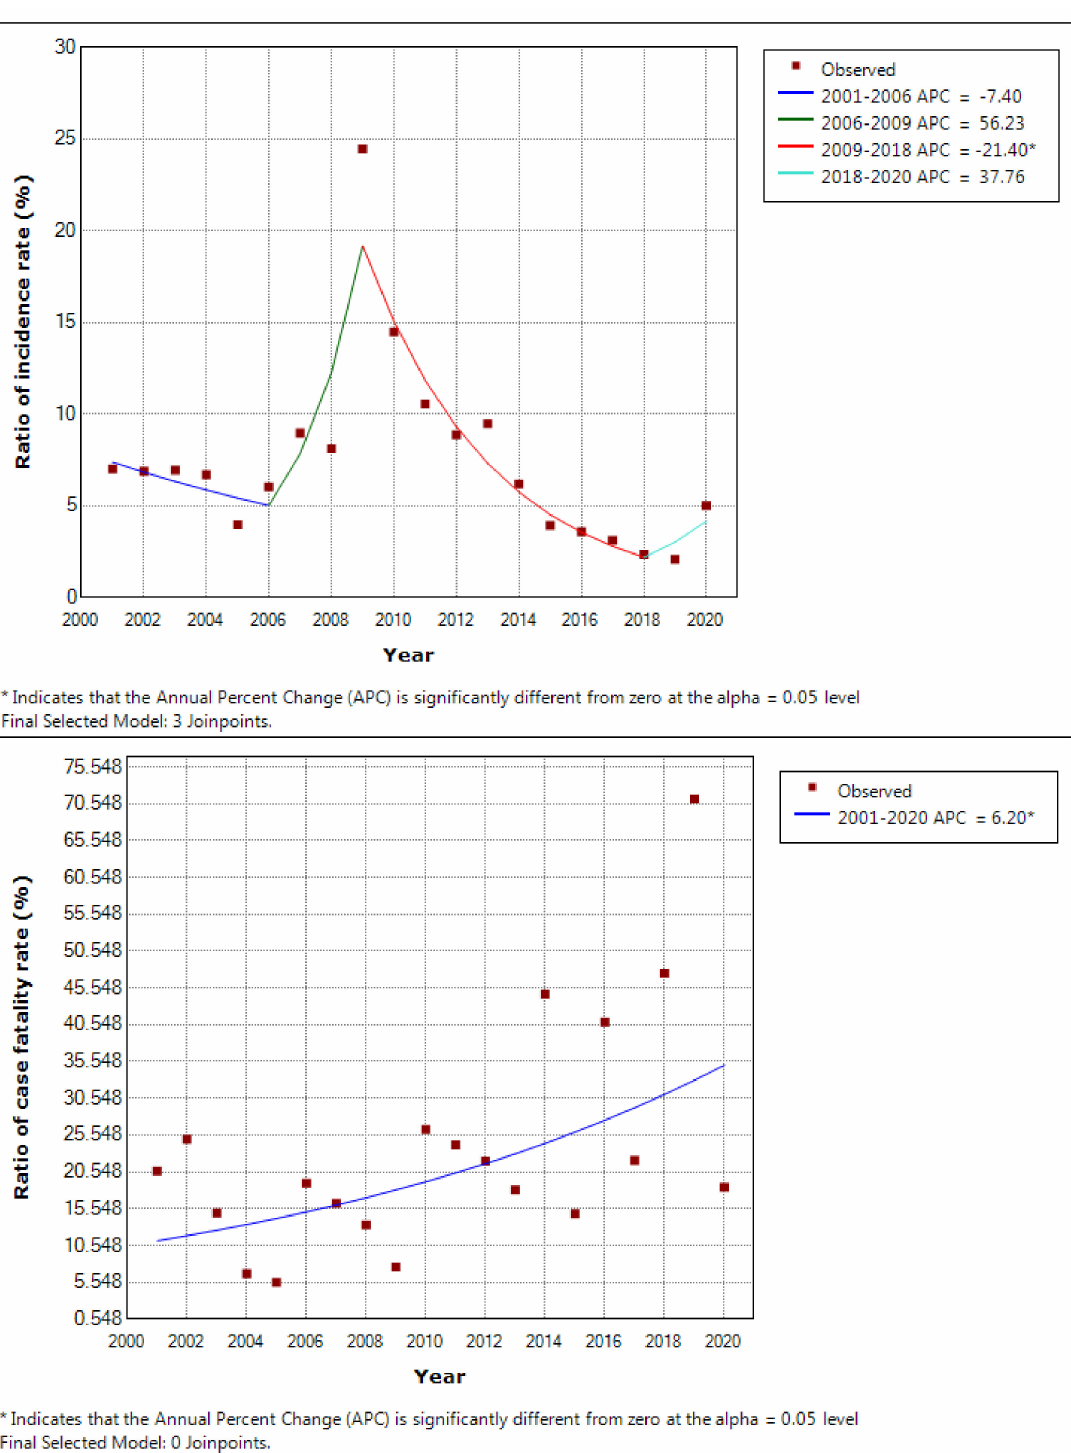
Figure 5. The trends of ratios of the incidence and fatality rate of infectious disease to all occupational diseases analysed by joinpoint